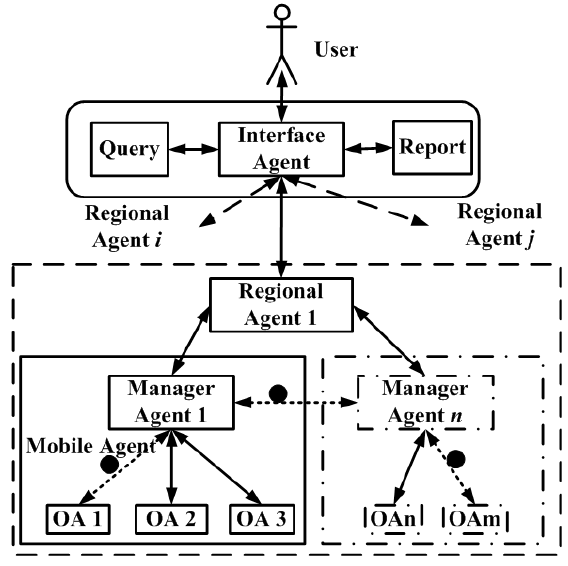
Figure 3. Heterogeneous agent architecture for WSN.